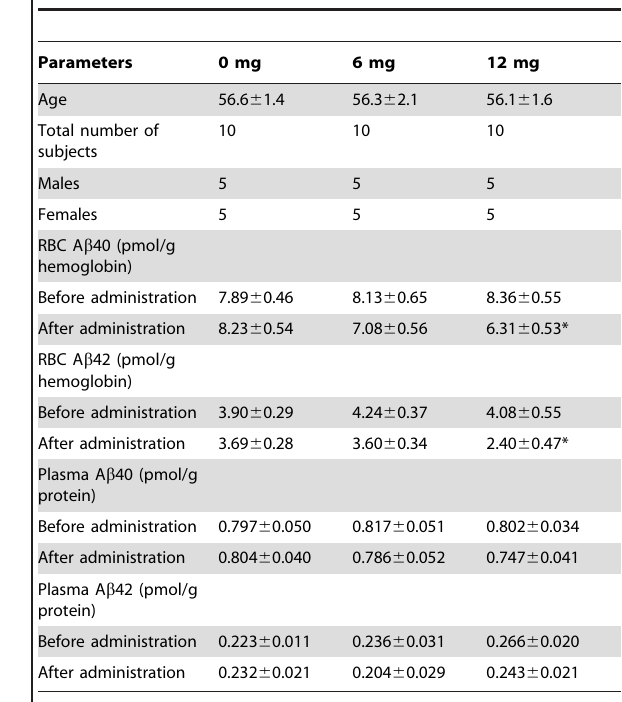
Table 2. Changes in Amyloid b levels in RBC and plasma before and after a 12 week administration of 0, 6 or 12 mg